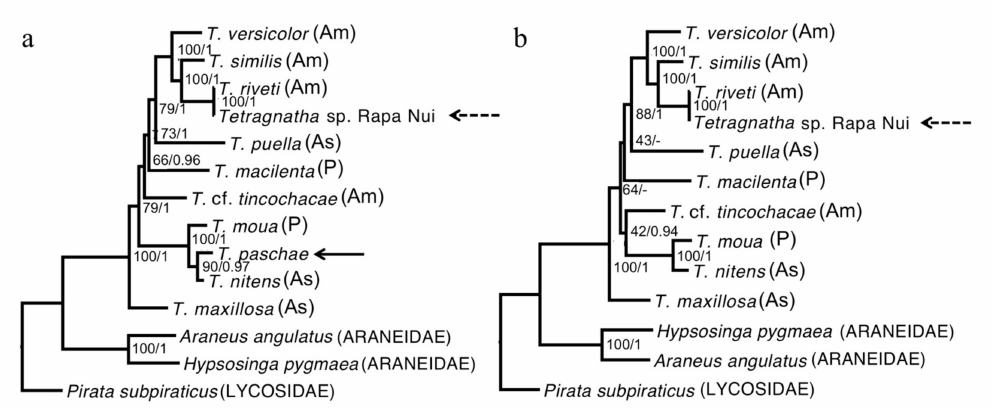
Figure 2. Maximum likelihood reconstruction. ( a ) Relaxed consensus including T. paschae . ( b ) Strict consensus not including T. paschae. The node values represent the bootstrap support/Bayesian posterior probability. As: Asia; Am: America; P: Pacific.